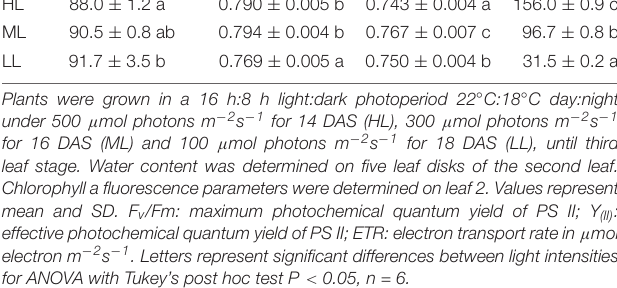
TABLE 1 | Water content and fluorescence parameters of cv. Propino plants grown under different light intensities. Water content (%)